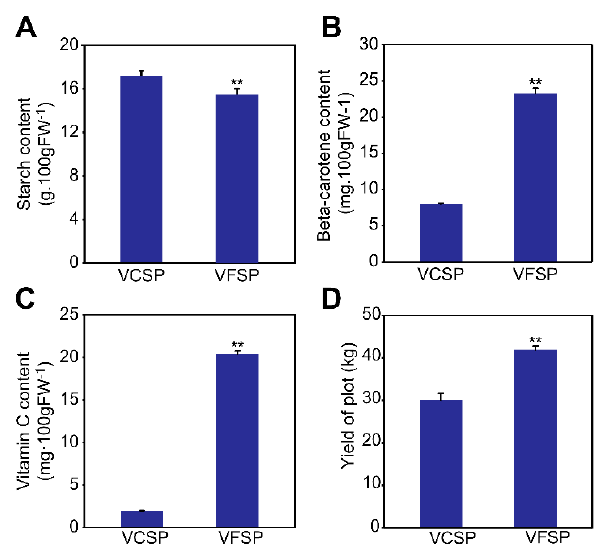
Figure 2. Comparison of yield and quality of VCSP and VFSP storage roots. ( A ) Content of starch. ( B ) Content of beta-carotene. ( C ) Content of vitamin C. ( D ) Yield of plot. Three independent experimental replicates were analyzed for each treatment, and data are indicated as the mean ± SE ( n = 3). Independent t -test was performed to check difference between VFSP and VCSP (** p < 0.01; * p < 0.05).